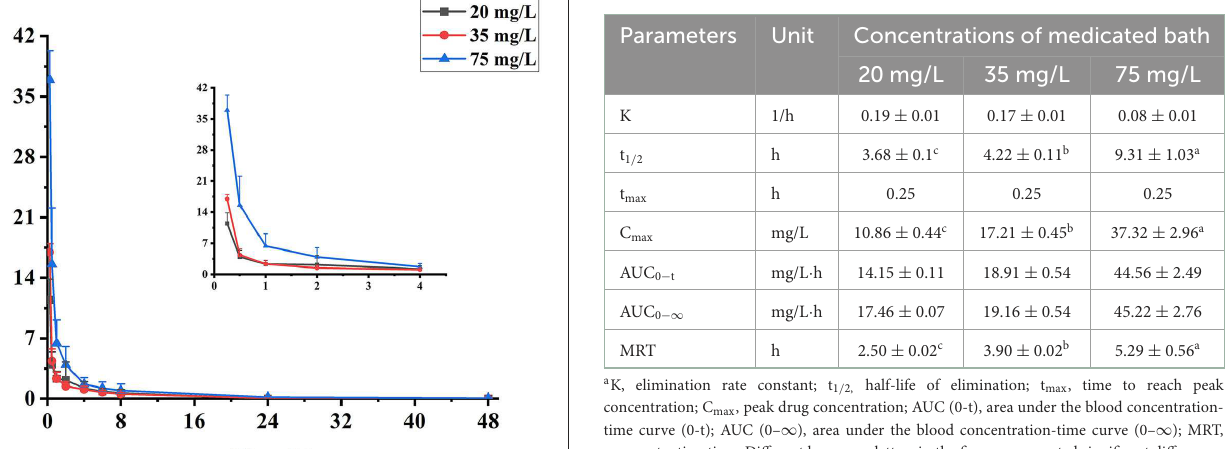
TABLE 2 Pharmacokinetic parameters of eugenol in the carp plasma ( n = 10) a